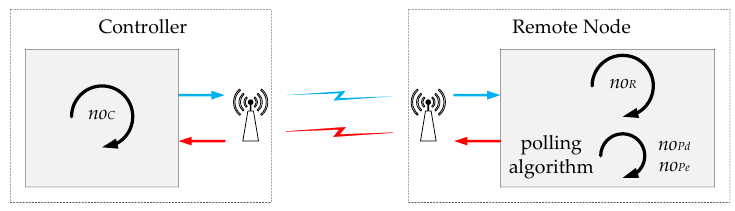
Figure 5. Computational resources